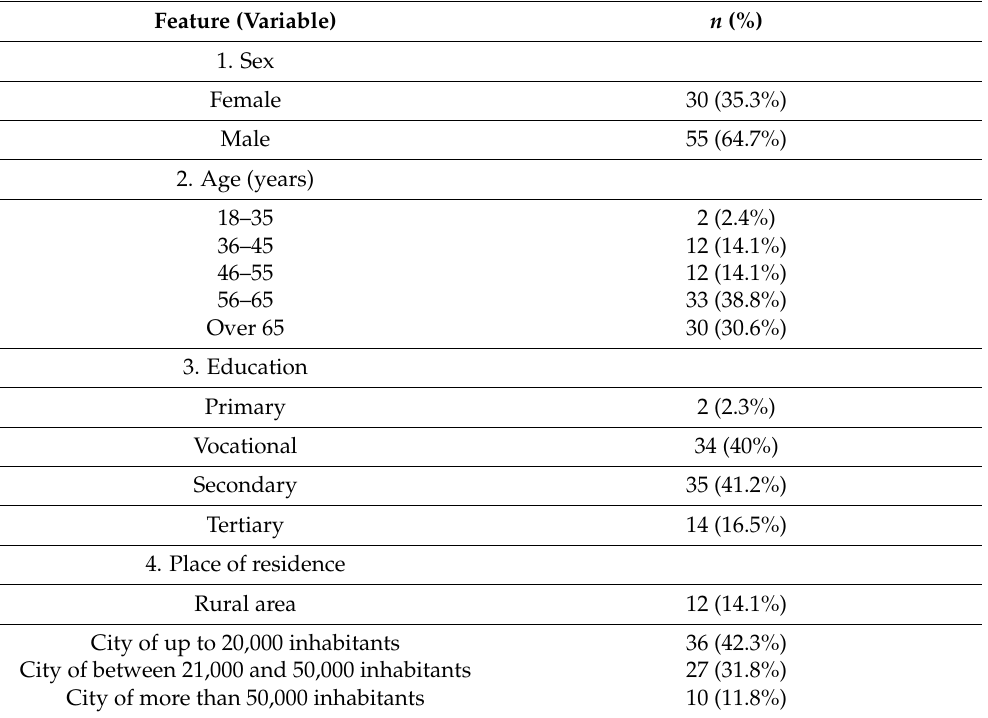
Table 1. General sociodemographic characteristics of the